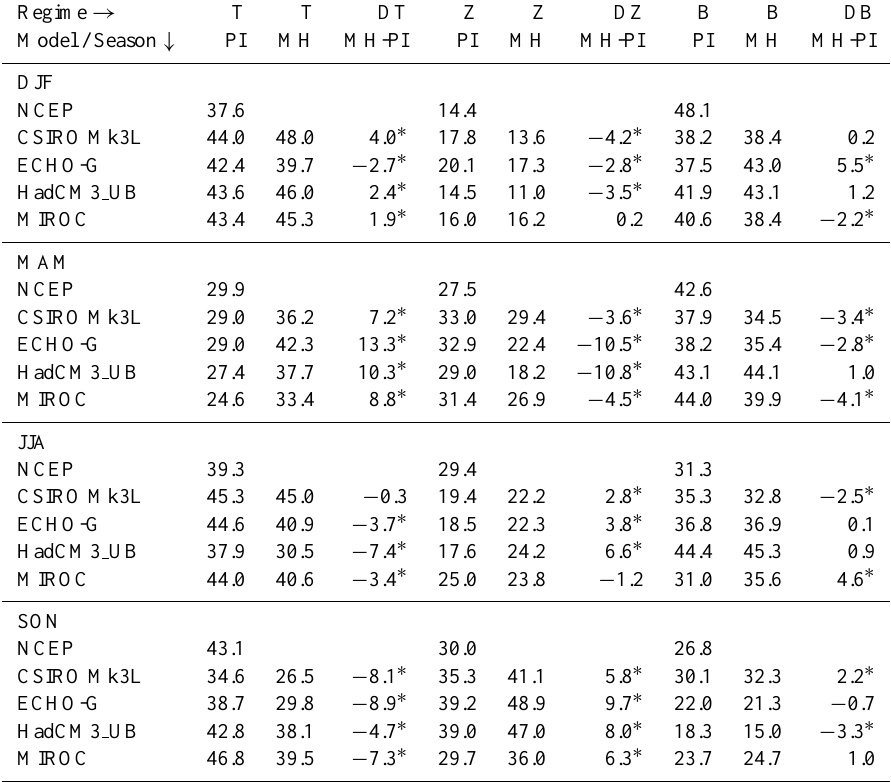
Table 2. The frequency of occurrence (%) of the Trough (T), Zonal (Z) and Blocking (B) regimes in the pre-industrial control (PI) and Mid-Holocene (MH) runs for each model. The change in the frequency of occurrence (%) of each regime (DT, DB and DZ) for the MH relative to the PI is also included for each model. The frequency of occurrence of each regime, derived from NCEP reanalysis data from 1972–2009, are also given (seasonally) before the model values are